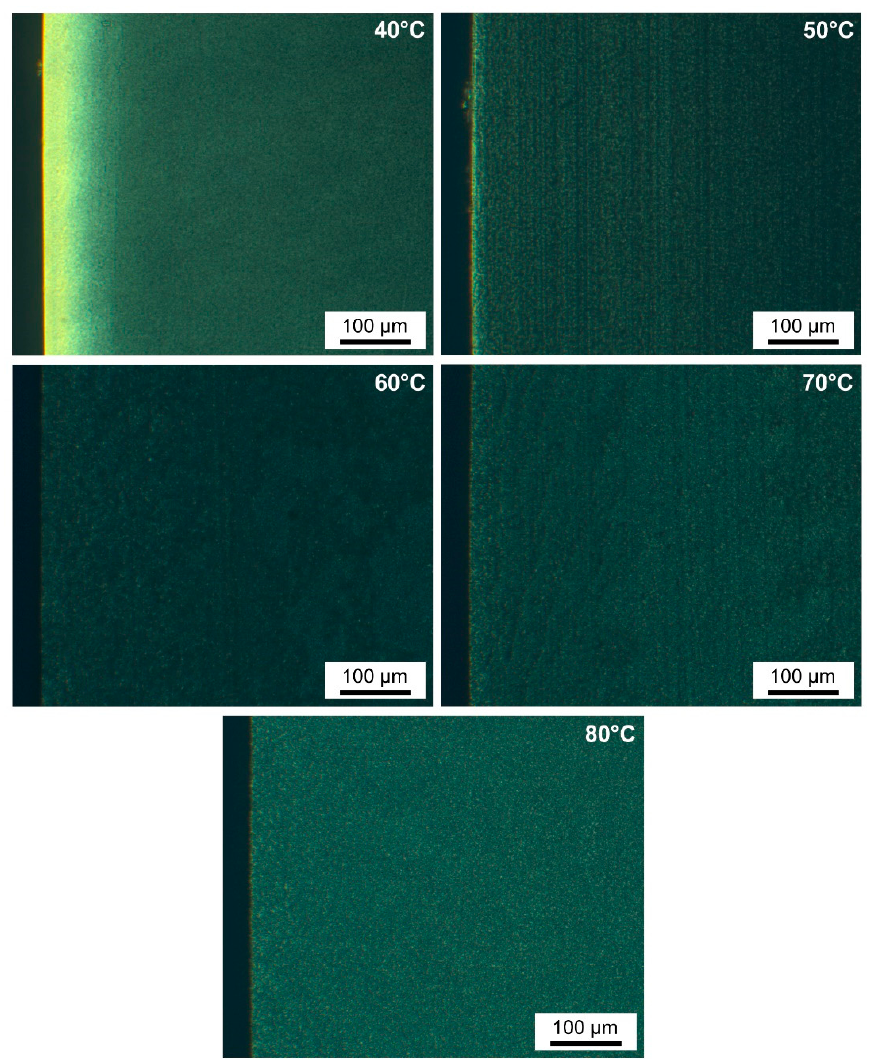
Figure 8. POM micrographs with 20 × zoom on 40 µ m thin sections for mold temperatures M ranging from 40–80 °C.